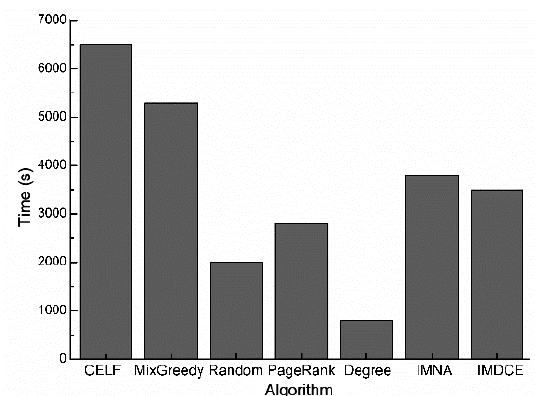
Fig. 7 Comparison of the running times of different